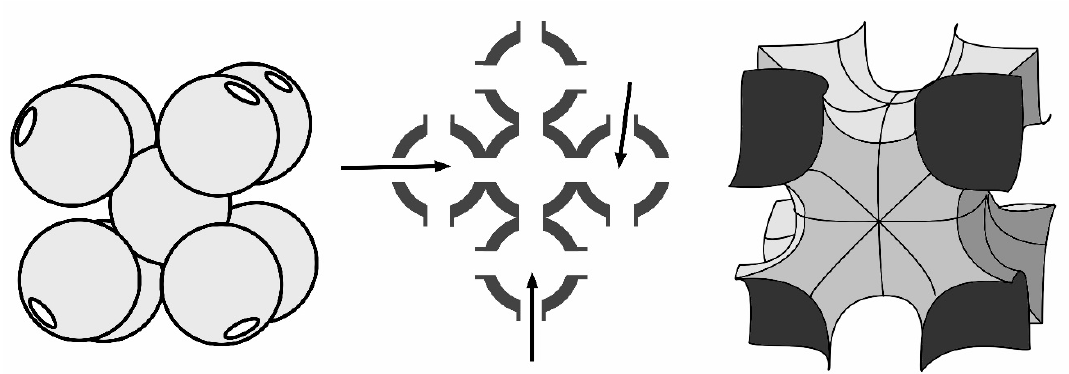
Figure 2. Structure of the SBA-16 (SBA—Santa Barbara Amorphous) material and scheme of Schoen’s I-WP (WP—wrapped package) minimal surface.